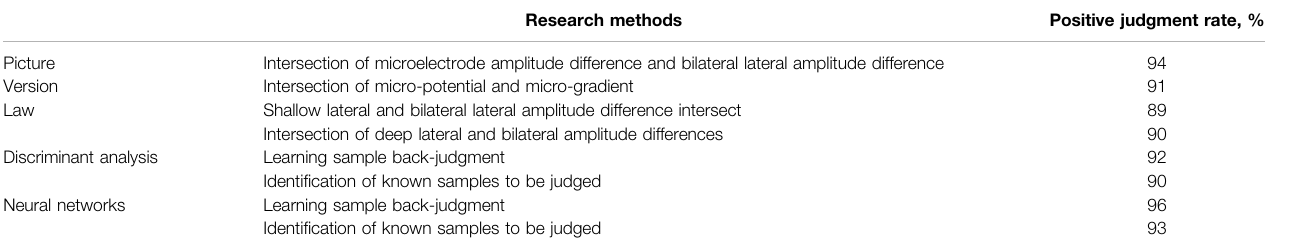
TABLE 3 | Comparative analysis of discriminant errors of various research